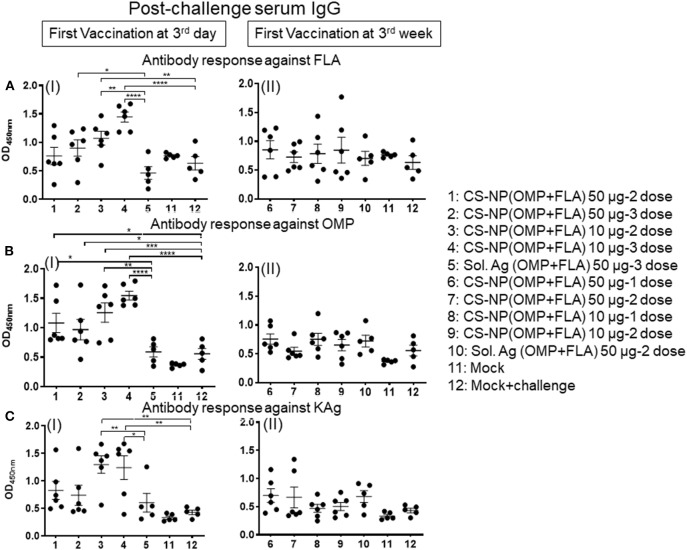
Specific IgG response in vaccinated birds post-challenge infection. Broilers were vaccinated as described in Fig legend 1, challenged at age 5-week, 10 days later euthanized and serum samples collected were analyzed for specific IgG antibody response by ELISA: against (A) FLA protein (I and II), (B) OMP (I and II), and (C) KAg (I and II). Data were presented as mean ± SEM of 6 or 5 birds. Significant difference between the indicated two groups were determined by one-way ANOVA followed by Tukey post-hoc test. *P < 0.05, **P < 0.01, ***P < 0.001, ****P < 0.0001.